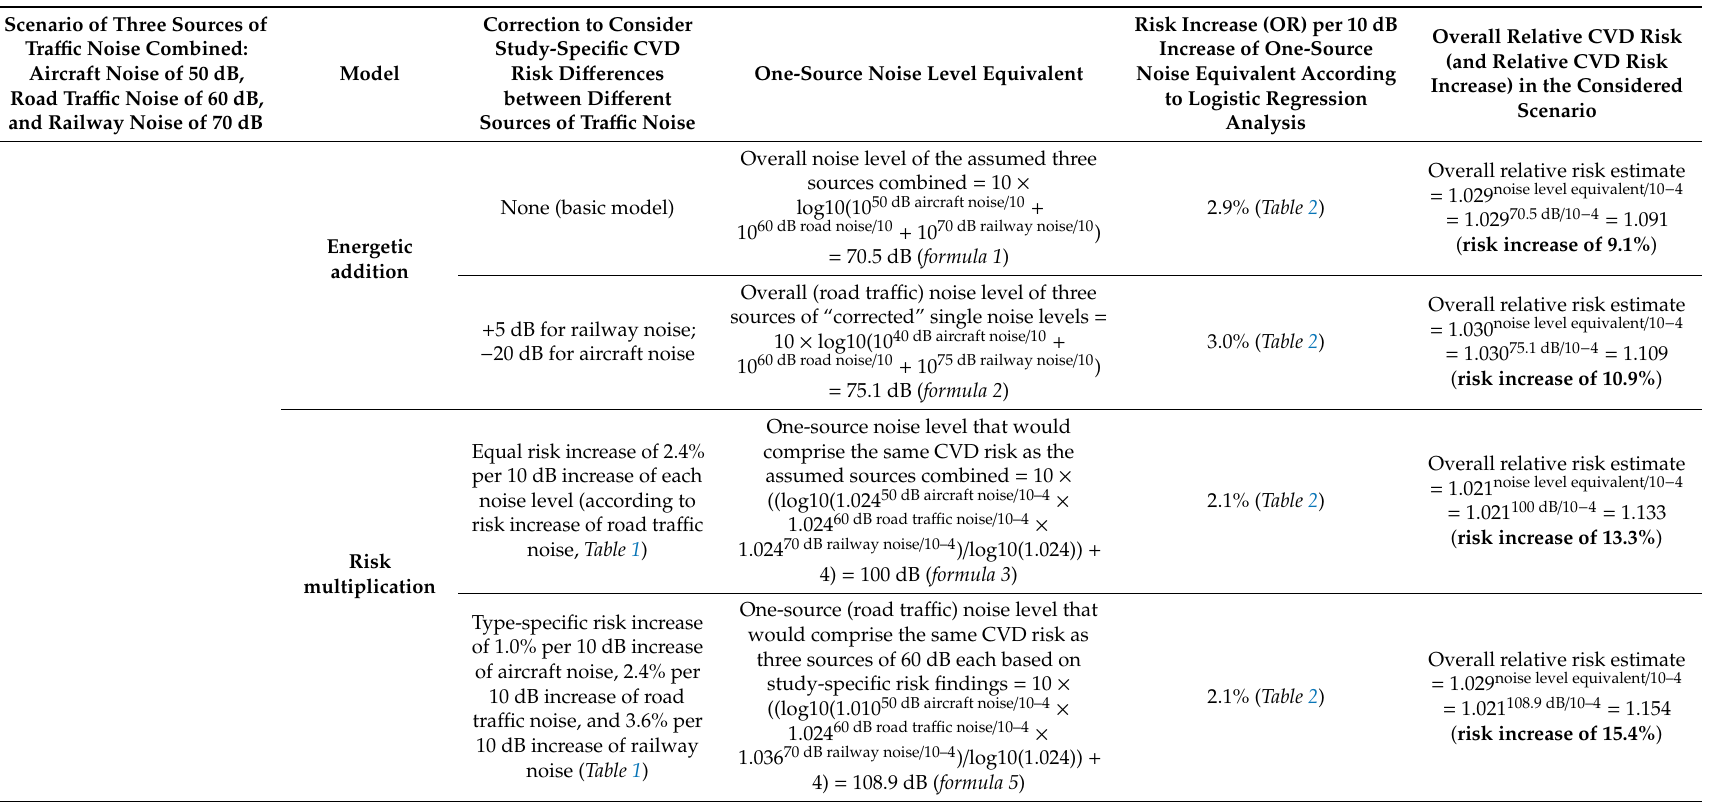
Table 4. Example of the di ff erent disease risks derived by the two di ff erent models for the example scenario with 24 h-continuous noise pressure levels for aircraft